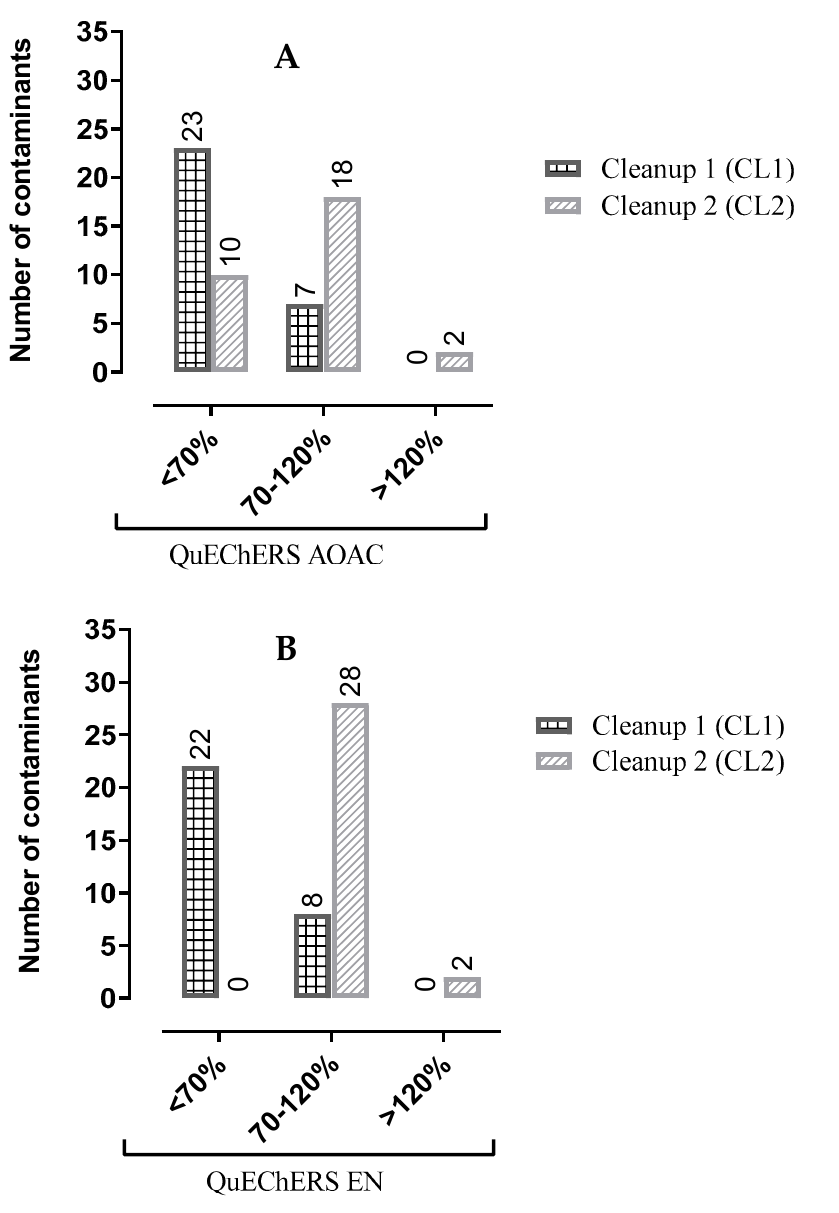
Figure 4. Number of contaminants obtained in the ranges lower than 70%, between 70 and 120% and higher than 120%, using QuEChERS AOAC ( A ) and EN ( B ).